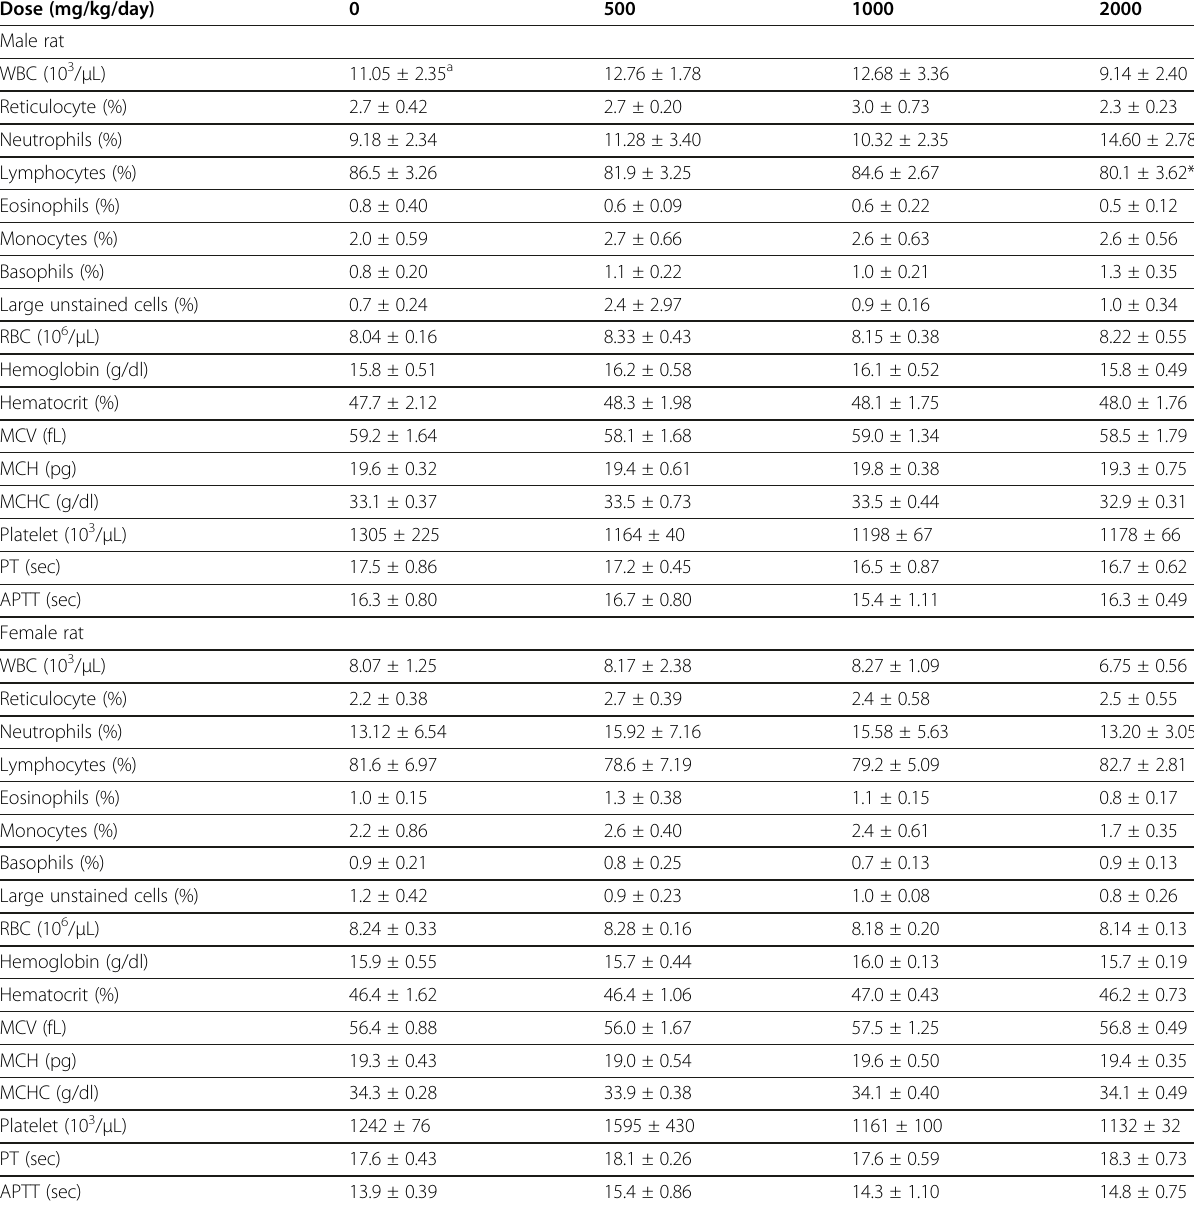
Table 3 Hematological values of animals treated with SST for 4 weeks Dose